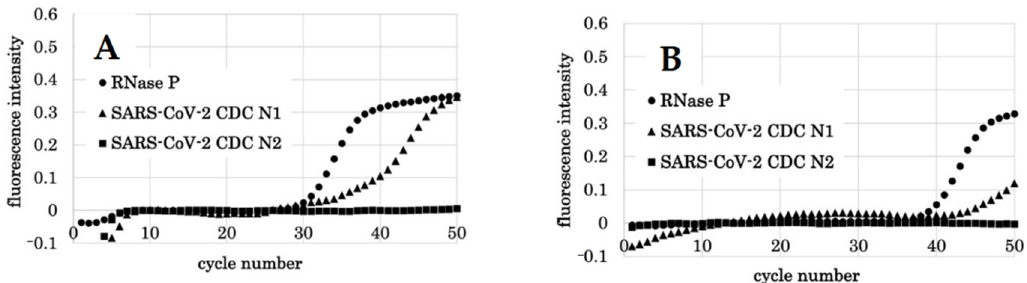
was no problem with the PCR reaction. CDC N1 was not detected. no problem with the PCR reaction. CDC N1 was not detected.